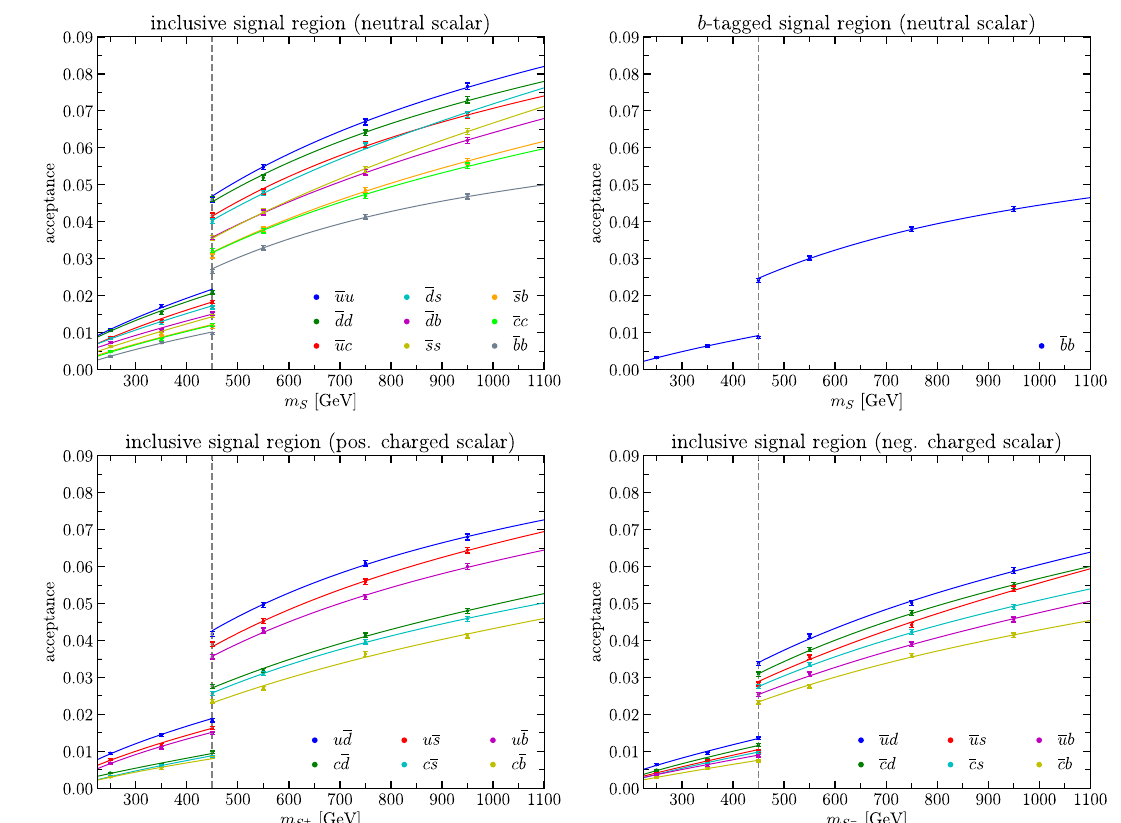
Fig. 3 The acceptance of the ATLAS search for a resonance with a di-jet final state produced in association with a photon. For this Figure, the scalar resonance is assumed to couple to only one type of quark pair (see legend). The points are used to denote parameter points for whichexplicitMCsampleshavebeengenerated.Thelinesrepresentthe